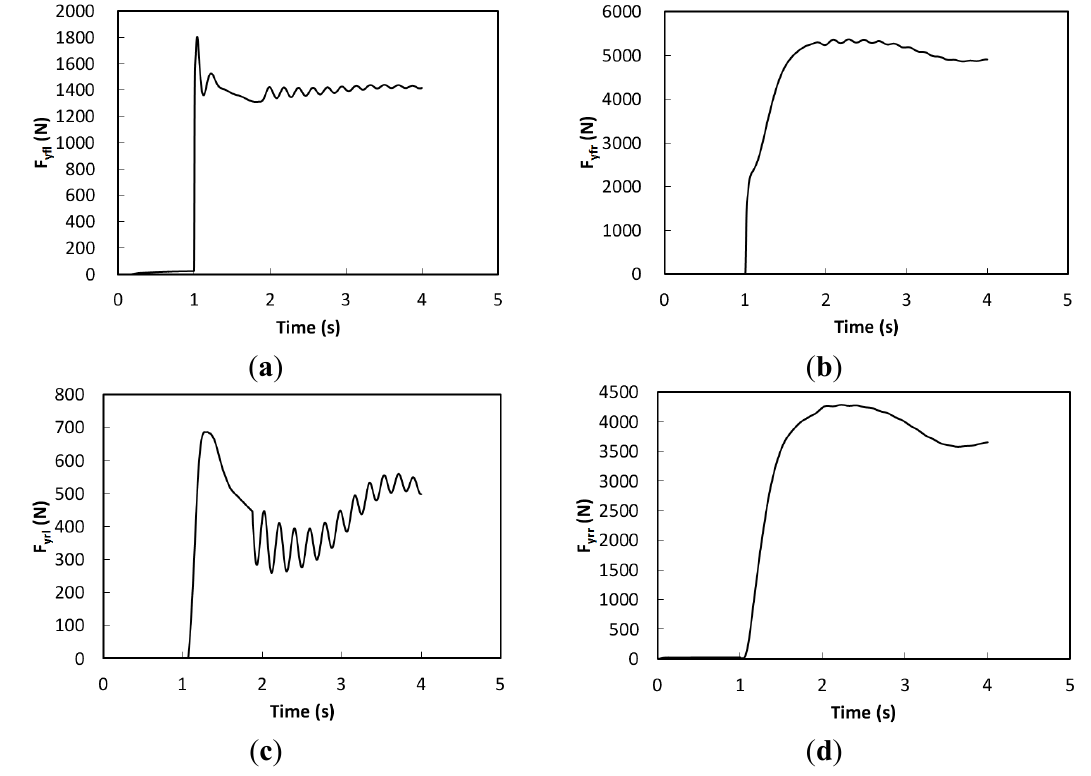
Figure 17. The lateral tire forces without control. ( a ) Front left wheel; ( b ) Front right wheel; ( c ) Rear left wheel; ( d ) Rear right